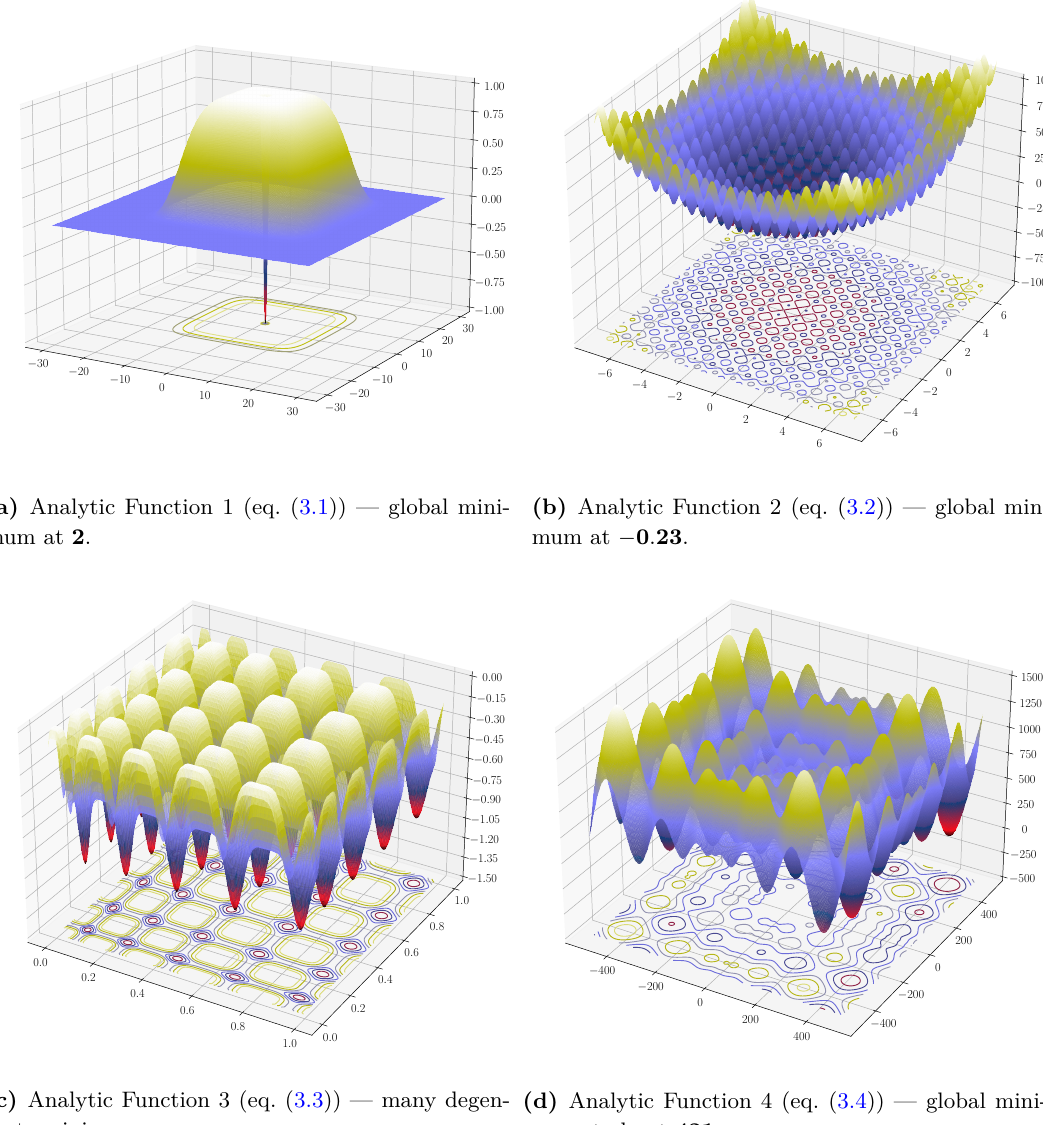
(d) Analytic Function 4 (eq. (3.4)) — global mini- mum at about 421 .